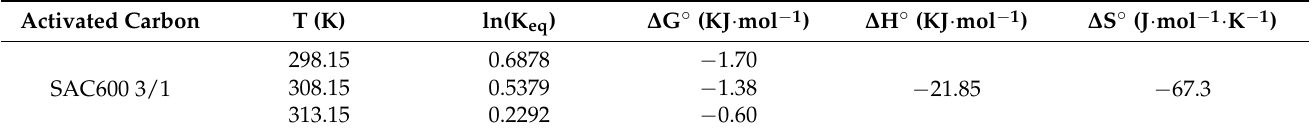
Table 5. Thermodynamic